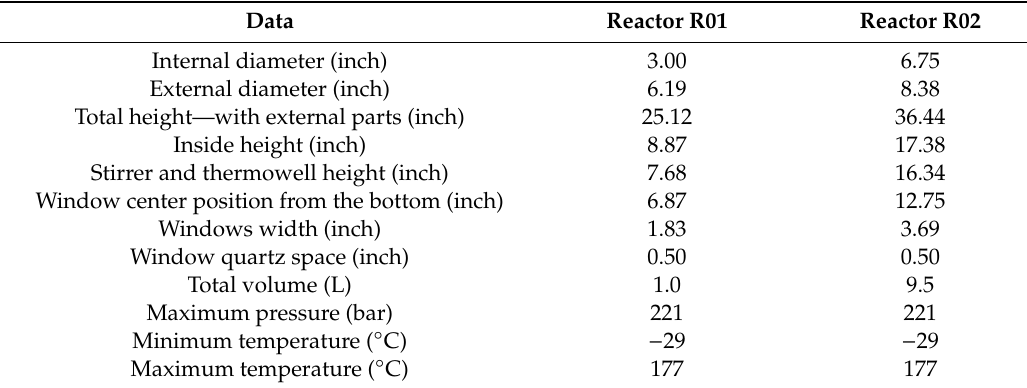
Table 1. Main design information about both reactors.